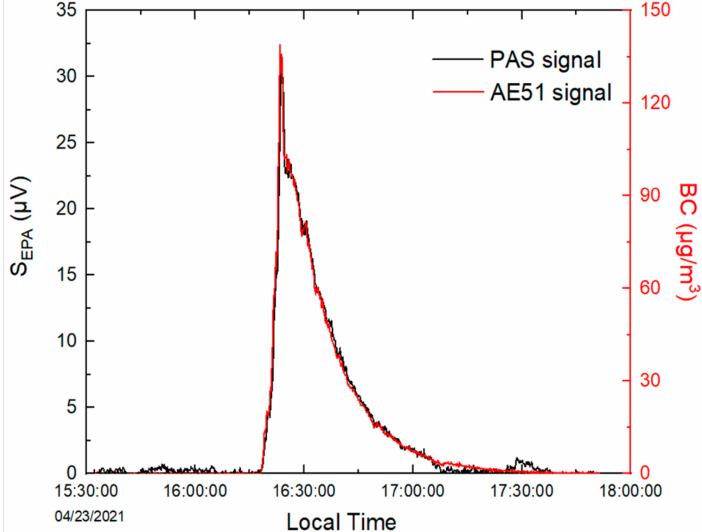
Figure 7. Time series of measurements for incense-generated BC by PASS and